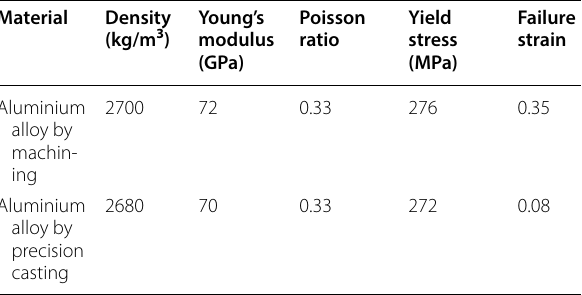
Table 2 Material properties of the two aluminum alloys Material